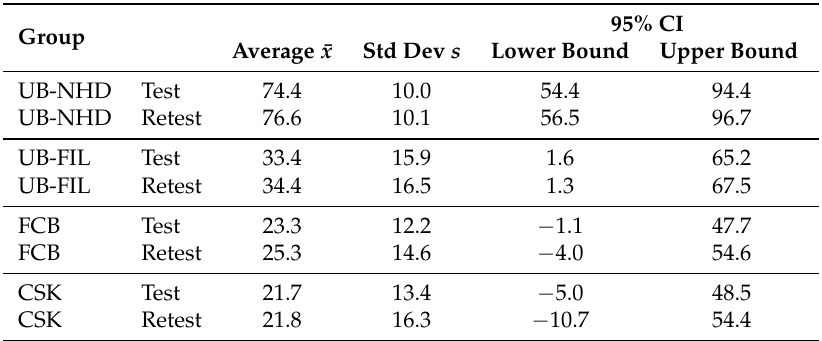
Table 3. Test and retest statistics of the four groups of subjects included in this validation study. It is apparent that UB-NHD ranks consistently higher on nutrition